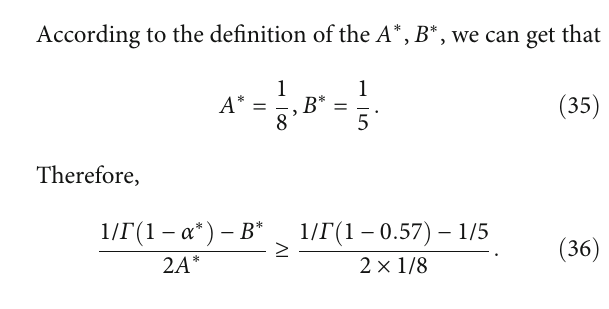
Figure 1: Picture of the function α ∗ ð u Þ